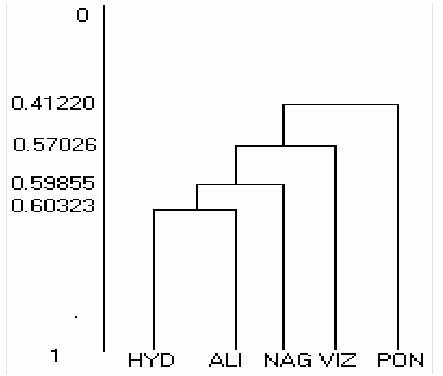
Fig. 5. Dendogram for horizontal H-component.